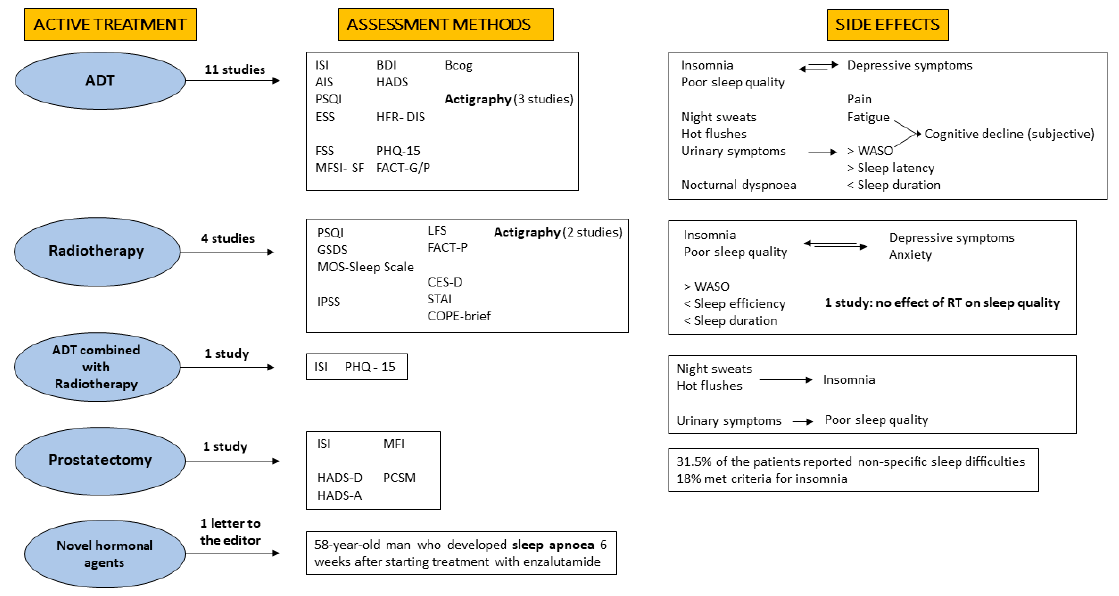
Figure 2. Sleep disturbances in prostate cancer active treatments: graphical summary of the literature synthesis. Androgen deprivation therapy (ADT), Insomnia Severity Index (ISI), Athens Insomnia Scale (AIS), Pittsburgh Sleep Quality Index (PSQI), Epworth Sleepiness Scale (ESS), Fatigue Severity Scale (FSS), Multidimensional Fatigue Symptom Inventory—Short-Form (MFSI-SF), Beck’s Depression Inventory (BDI), Hospital Anxiety and Depression Scale (HADS), Hot Flash Related Daily Interference Scale (HFR-DIS), Physical Symptoms Questionnaire (PHQ-15), Functional Assessment of Cancer Therapy—General (FACT-G), Functional Assessment of Cancer Therapy—Prostate (FACT-P), Brief Scale for Cognitive Evaluation (BCog), General Sleep Disturbances Scale (GSDS), Medical Outcomes Survey—Sleep Scale (MOS-Sleep Scale), International Prostate Symptom Score (IPSS), Lee Fatigue Scale (LFS), Center for Epidemiological Studies—Depression Scale (CESD), Spielberg State-Trait Anxiety Inventories (STAI), Coping Orientation to Problems Experienced Inventory—brief (COPE-brief), Hospital Anxiety and Depression Scale (HADS-D), Hospital Anxiety and Anxiety Scale (HADS-A), Multidimensional Fatigue Inventory (MFI), Prostate Cancer-Specific Module (PCSM), Wake After Sleep Onset (WASO), Radiotherapy (RT).